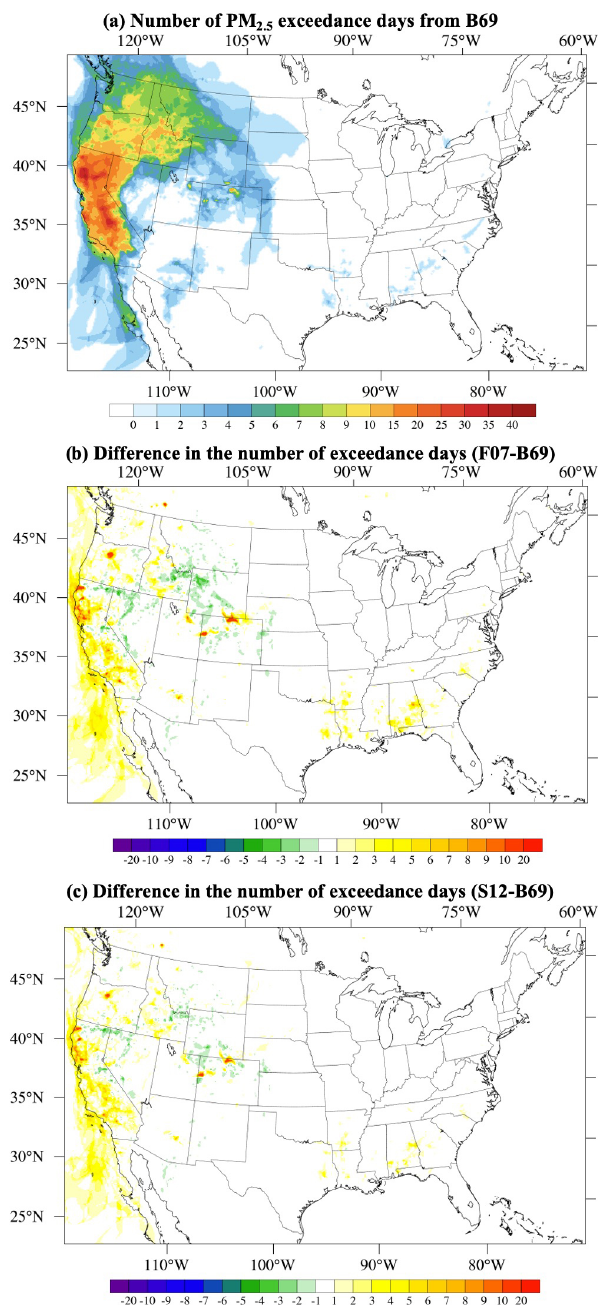
Figure 12. The CMAQ B69-predicted total number of PM 2 . 5 ex- ceedance days during August–September 2020 (a) . The difference in the number of predicted exceedance days between B69 and F07 (b) and between B69 and S12 (c) .